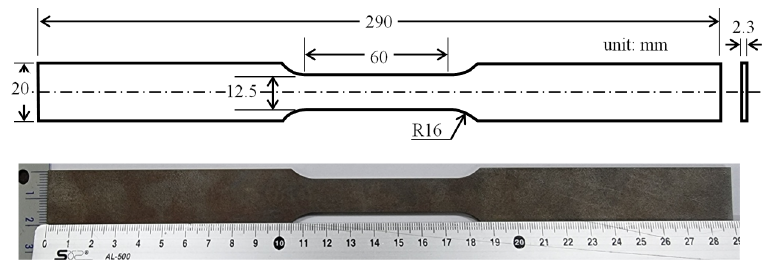
Figure 3. Tensile specimen used to measure equivalent stress–strain behavior of 3.0 wt% silicon